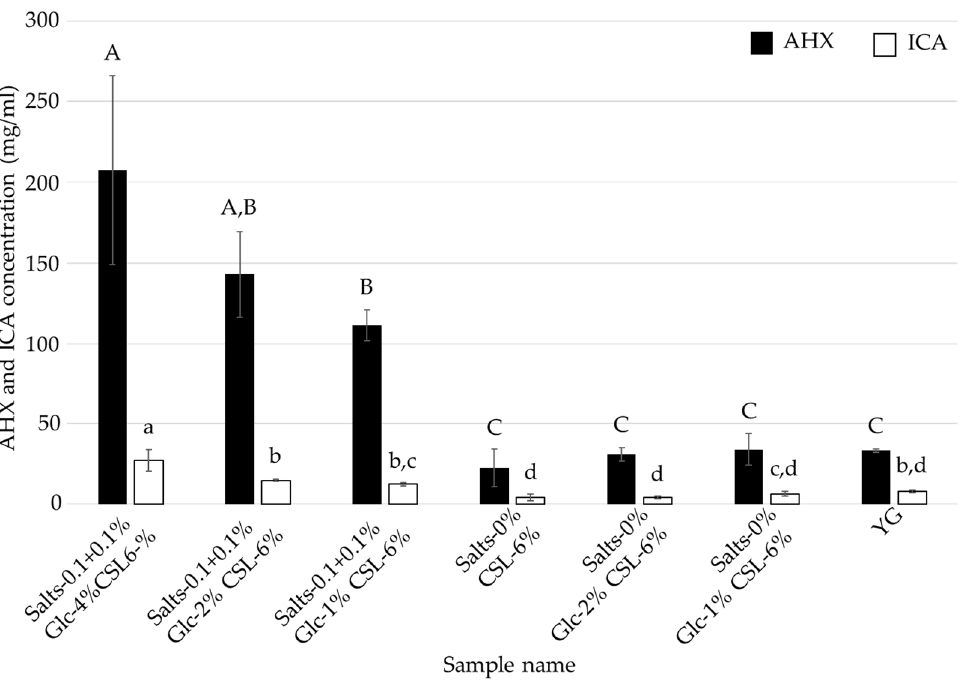
Figure 8. AHX and ICA contents of the culture filtrates of L. sordida mycelia cultured in CSL-6% media with reduced concentrations of glucose and inorganic salts. Different alphabet letters (capital letters for AHX, and small letters for ICA) indicate significant differences (Tukey–Kramer post hoc test, p < 0.05; n = 3).